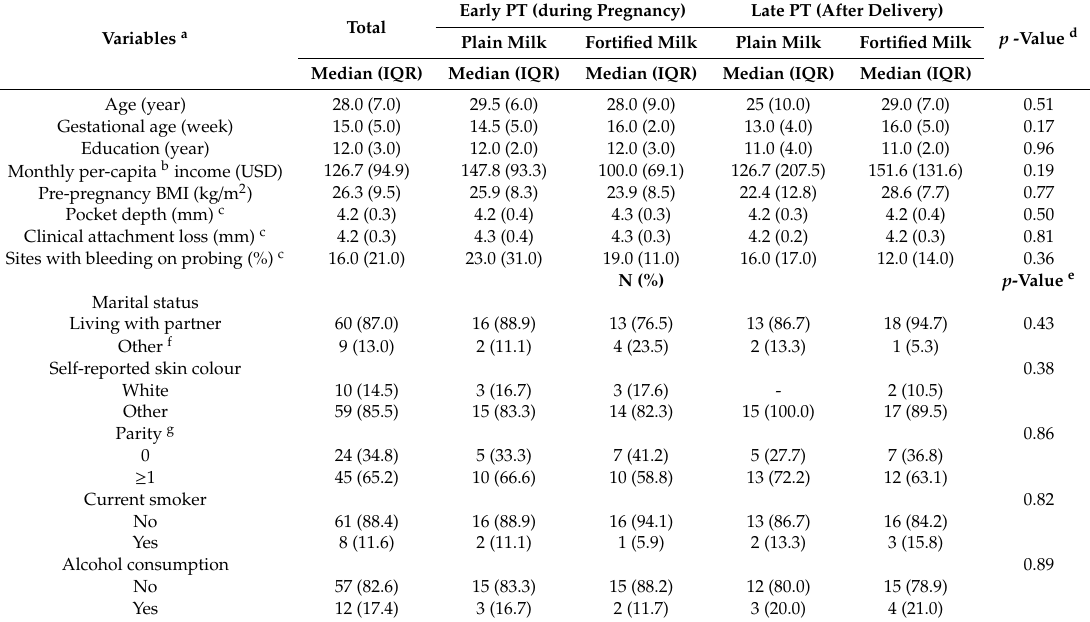
The baseline period was between gestational weeks 6 and 21. BMI, Body Mass Index. IQR, Interquartile range (the di ff erence between upper and lower quartiles). a n = 69; b value originally measured in Brazilian Reais (BRL) but converted to USA dollars (USD). Exchange rate in February 2019, BRL 3.75 = USD 1; c n = 67; d Kruskal–Wallis test; e Qui-squared test. f Other, not living with a partner, or do not have a partner. g Parity, number of parturitions. Completers (n = 55) did not significantly di ff er from those who dropped out (n = 15)